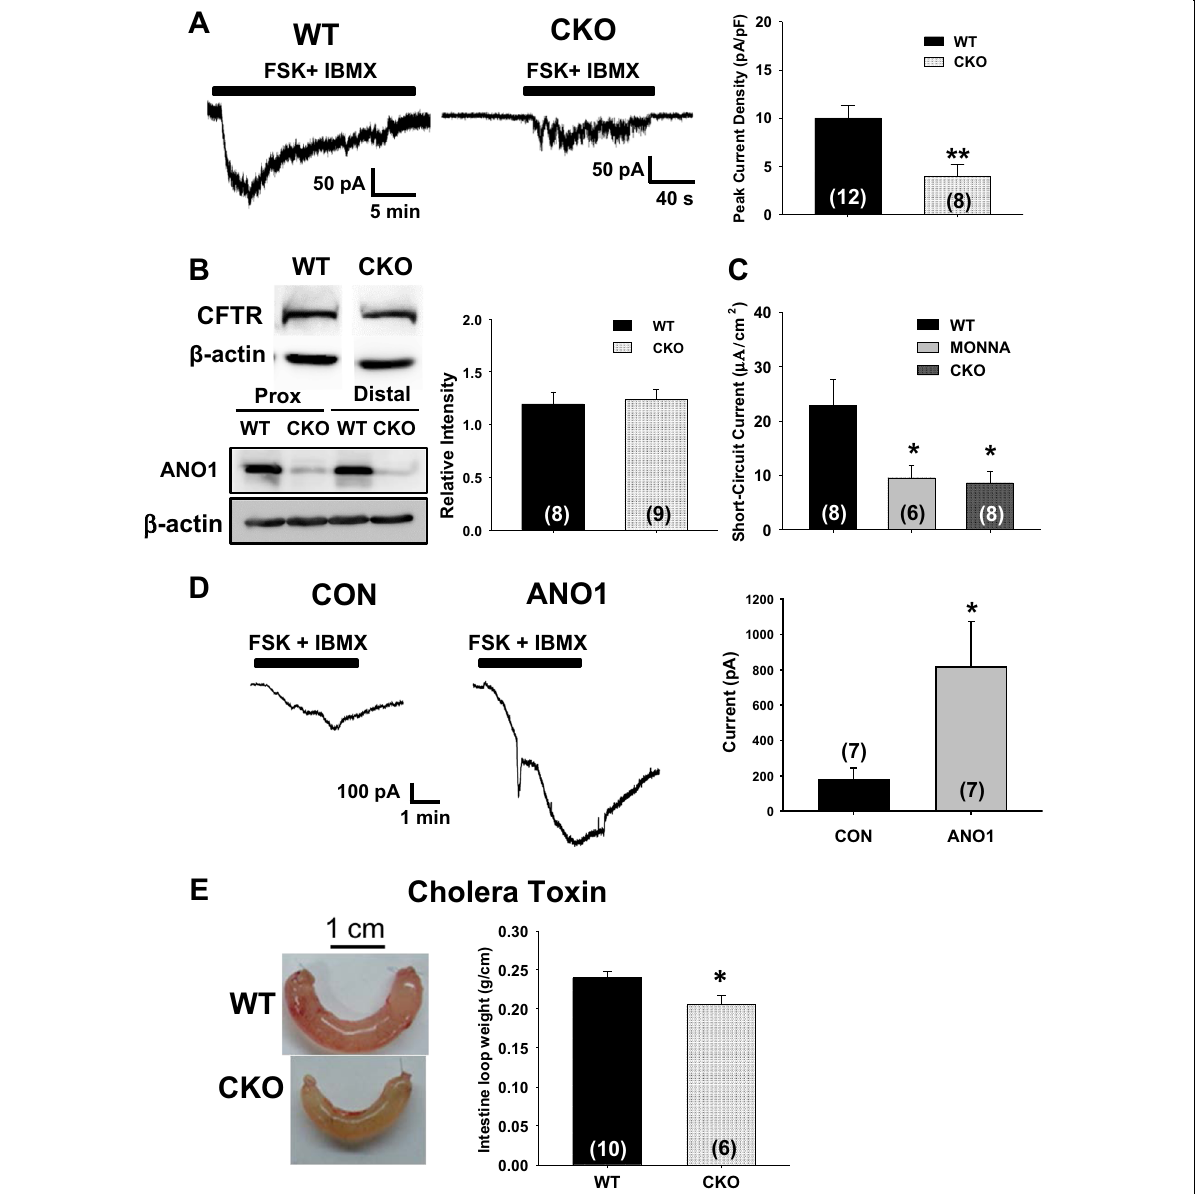
Fig. 4 cAMP-dependent Cl − and fl uid secretion is reduced in the Ano1 -de fi cient intestine. a Whole-cell Cl – currents activated by the application of 5 μ M forskolin (FSK) and 1 mM IBMX to colonocytes of the proximal colon isolated from Ano1 fl / fl (WT) and Cdx2-Ano1 fl / fl (CKO) mice. (Right) Summary of the peak current responses of colonocytes from both genotypes of mice after the application of FSK and IBMX. ** p < 0.01. b Western blot of CFTR (~160 kDa) in colonocytes isolated from WT and CKO mice (upper panel) and ANO1 in the proximal and distal colon of both genotypes (lower panel). β -actin was investigated as a control. (Right) Summary of the intensities of blots performed with a CFTR antibody for colonocytes from both genotypes. The intensities of CFTR were normalized to that of β -actin. Whole blots of ANO1 and CFTR are shown in Supplementary Fig. 3. c Peak short-circuit currents ( I sc ) of proximal colons from WT and CKO mice induced by the application of FSK and IBMX to the serosal surface. The ANO1 blocker MONNA (100 µM) was added to the FSK- and IBMX-containing bath solution for the colons of WT mice. d Traces of whole-cell Cl − currents induced by FSK and IBMX in mock (control vector) or ANO1-transfected H293T cells. (Right) Summary of FSK and IBMX evoked Cl − currents in mock or ANO1-transfected H293T cells. e Fluid secretion induced by cholera toxin from a loop of jejunum isolated from WT and Villin- Ano1 fl / fl (CKO) mice. An intestinal loop was made at the jejunum after tying both ends approximately 4 cm apart. Cholera toxin (3 μ g) in 100 μ l of saline solution was injected into the intrajejunal loop. Six hours after injection, the intestinal loop was isolated, and its weight and length were measured. The ratio of weight (g) to length (cm) was considered an indication of fl uid secretion. (Right) Summary of the intestinal loops of WT and CKO mice. * p <